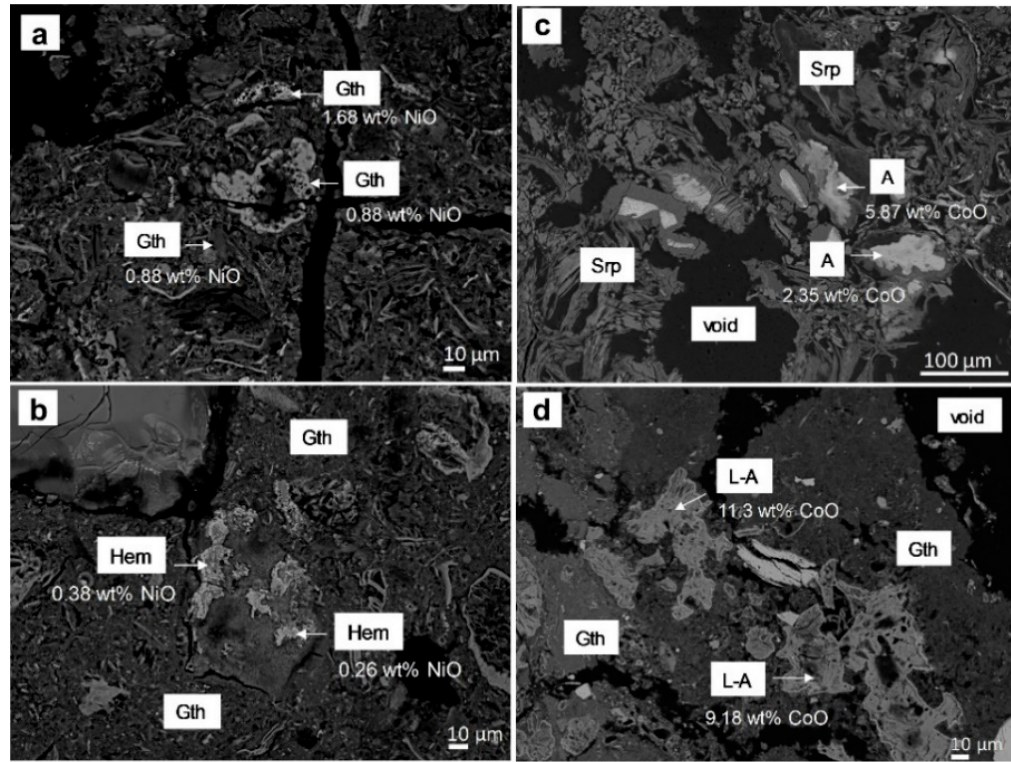
Figure 13. Backscattered electron images of ( a ) massive goethite (Gth) irregular aggregates of ( b ) hematite (Hem), ( c ) asbolane (A) in a serpentine (Srp) matrix and ( d ) lithiophorite-asbolane intermediate (L-A) in a goethite matrix.